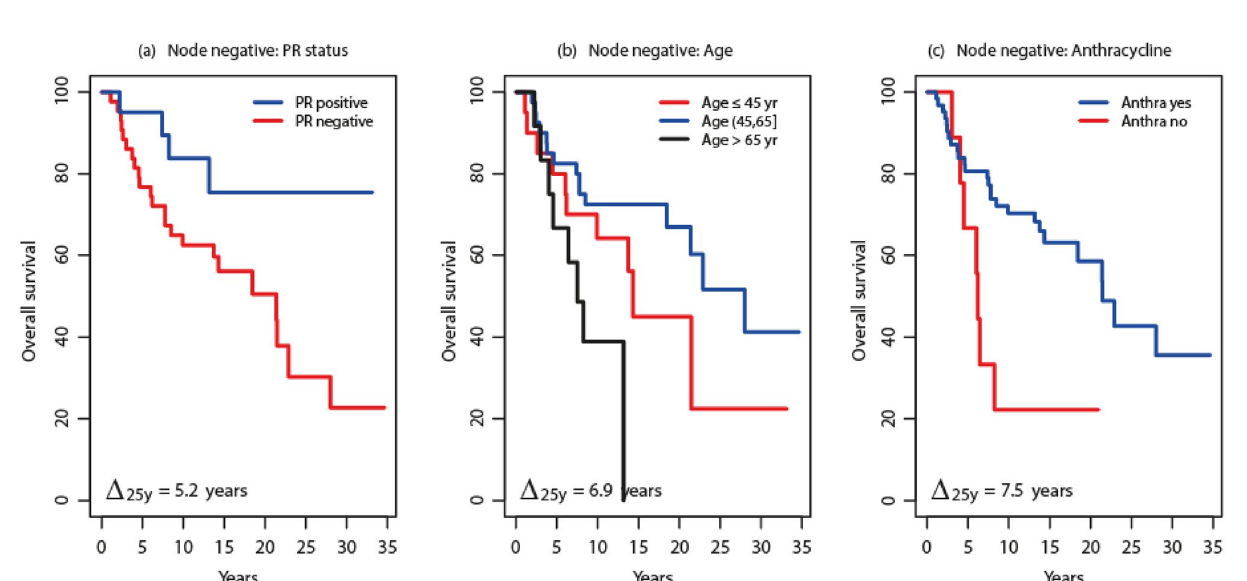
Figure 4. Survival among post-chemotherapy node-negative patients according to ( a ) progesterone receptor (PR), ( b ) age 45–65 years, and ( c ) receipt of anthracycline chemotherapy. Δ 25y , Gini’s mean difference of the restricted mean survival times at 25 years time